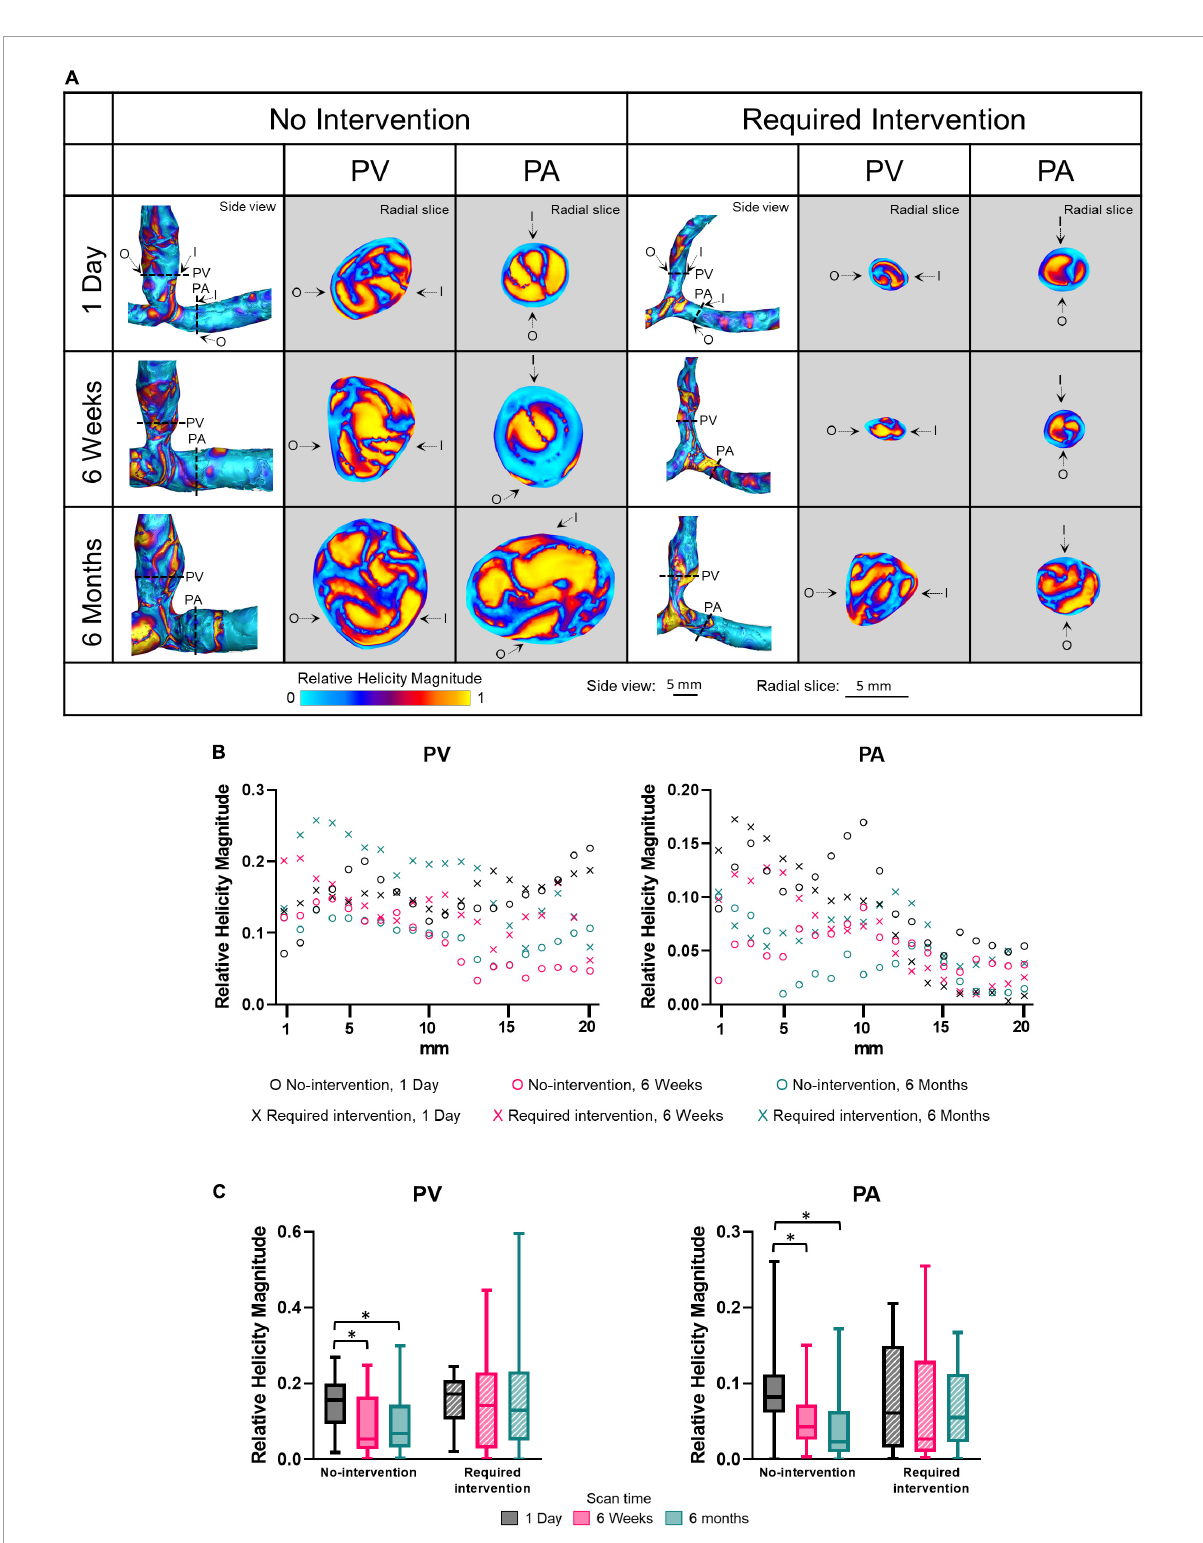
FIGURE7 Relative helicity magnitude of the proximal vein (PV) and proximal artery (PA). (A) The side view and radial slices of relative helicity magnitude color maps of representative arteriovenous fistulas at systole. Dotted lines in the side view color maps show the location of radial slices, approximately 5 mm from the anastomosis. O and I denote the locations of outer and inner walls, respectively. (B,C) Show relative helicity magnitude for the "no intervention" and "required intervention" groups at 1 day, 6 weeks, and 6 months, as explained in Figure 2 . ∗ P <